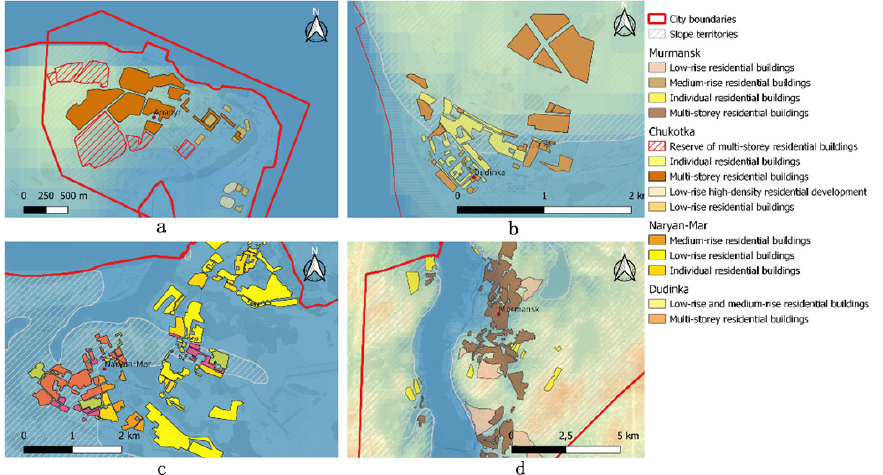
Figure 3. Topographic maps showing boundaries of residential areas in: ( a ) Anadyr, ( b ) Dudinka, ( c ) Naryan-Mar, and ( d ) Murmansk.